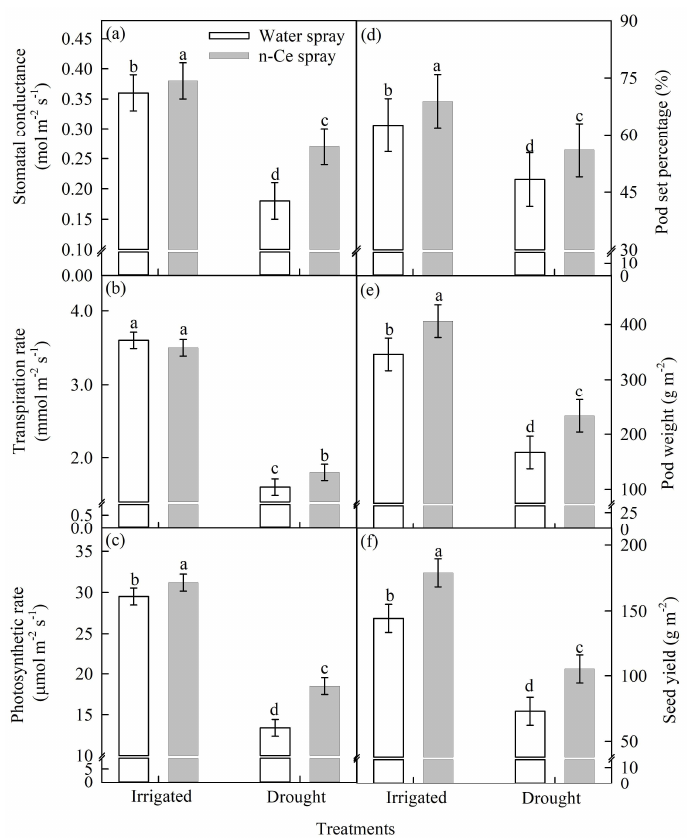
Figure 4. Effect of drought and foliar spray of nanoceria on ( a ) stomatal conductance (mol m −2 s −1 ), ( b ) transpiration rate (mmol m −2 s −1 ), ( c ) photosynthetic rate (µmol m −2 s −1 ), ( d ) pod-set percentage, ( e ) pod weight (g m −2 ), and ( f ) seed yield (g m −2 ) in mungbean (field experiment). Each value of the gas exchange is the mean ± SD of 45 independent measurements (3 replicates × 5 plants in each replicate × 3 observation times), and seed yield and its components are the mean ± SD of 30 inde- pendent measurements (3 replicates × 10 plants in each replicate). Means with different letters are significantly different at p ≤ 0.05.